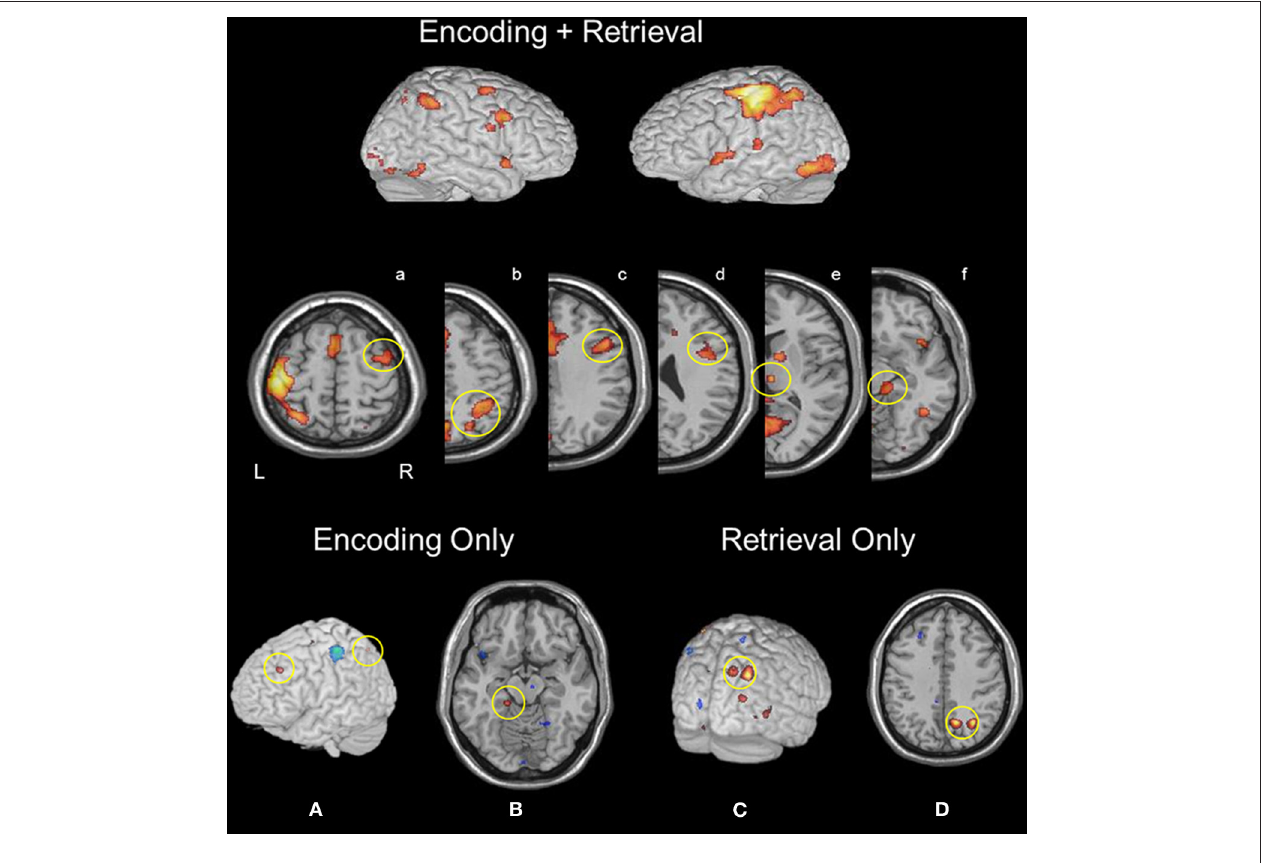
FIGURE 1 | Regions active during both memory encoding and retrieval: (a) rMFG, (b) right aIPS and pIPS, (c and d) rIFG, (e) right thalamus, and (f) right parahippocampus. Encoding selective activity